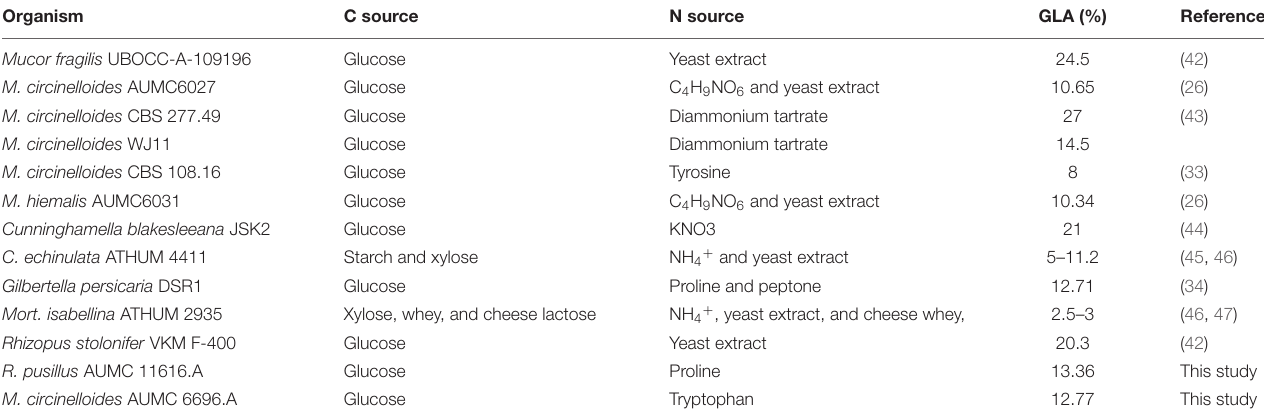
TABLE 2 | GLA comparative analysis among various studies by selected Mucromycota.